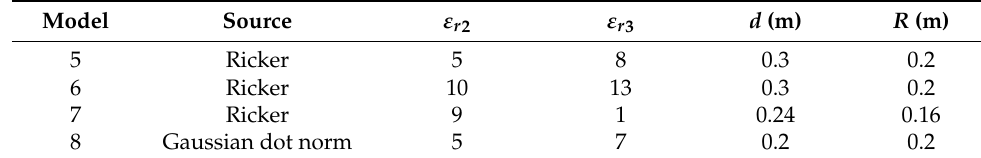
Table 1. Simulation parameters of derivative models 5–8.